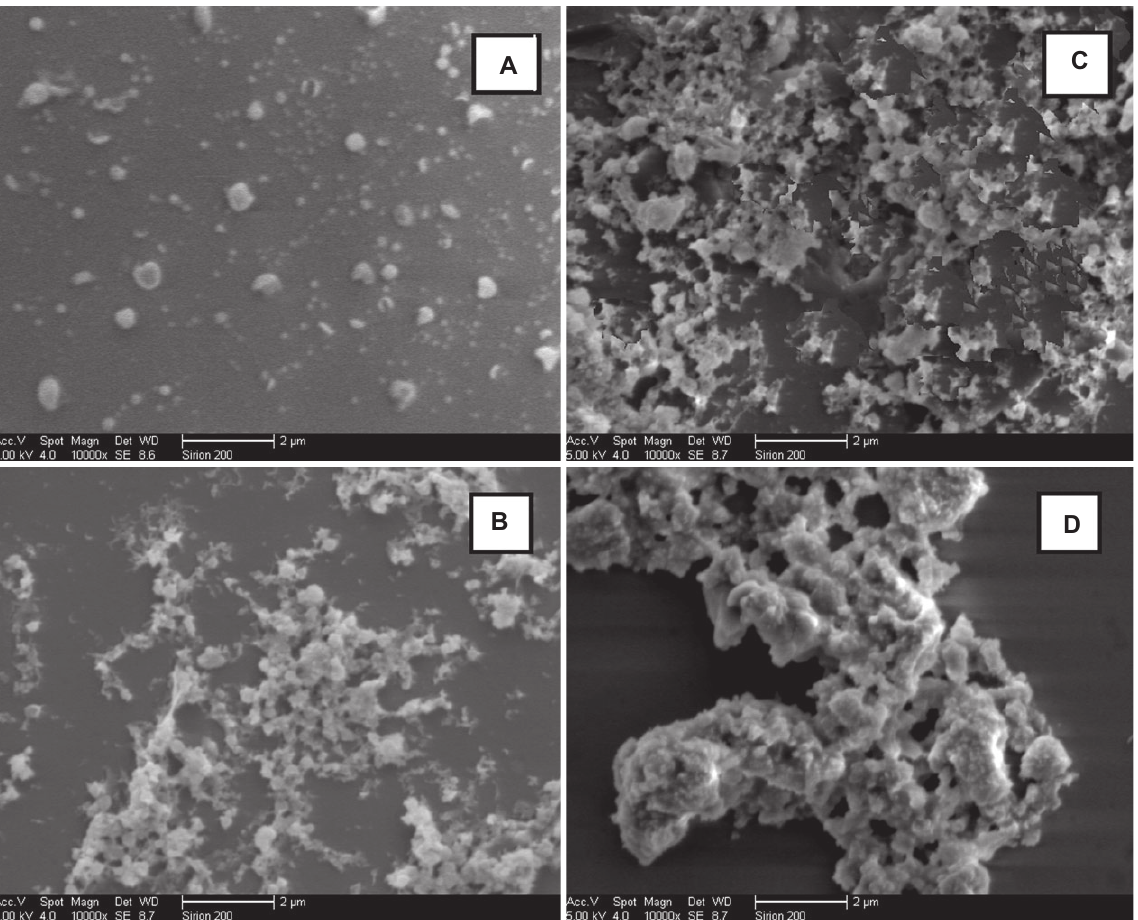
Figure 5 SEM images of HAp/PMMA nanocomposites ( × 40,000). (A) HAp/PMMA1.0 % ; (B) HAp/PMMA10 % ; (C) HAp/PMMA20 % ; (D) HAp/PMMA40 % .